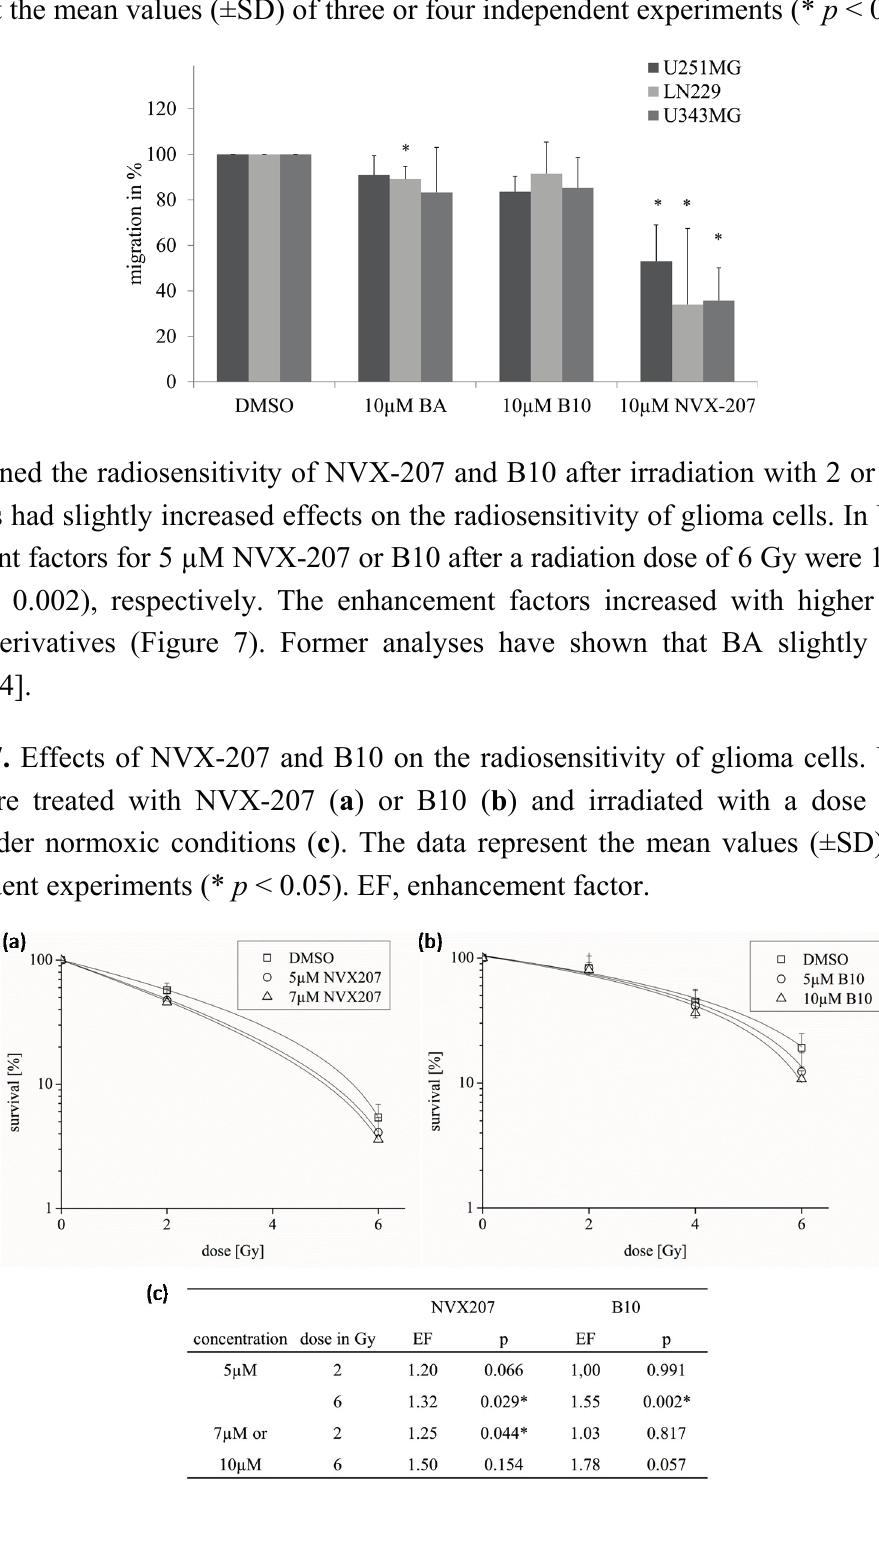
Figure 6. Effects of 10 µM BA, NVX-207 or B10 on the migration of glioma cells. The data represent the mean values (±SD) of three or four independent experiments (* p < 0.05).